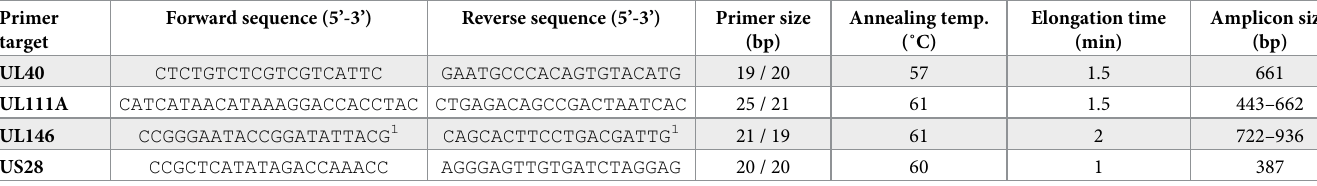
Table 1. Primers used for amplification of CMV target